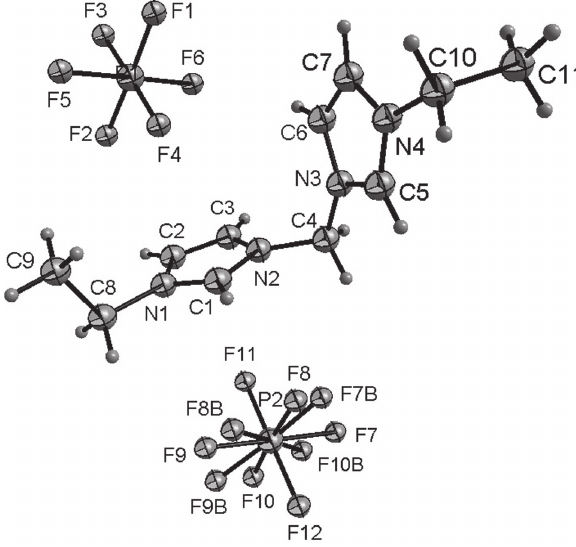
Table 1: Data collection and